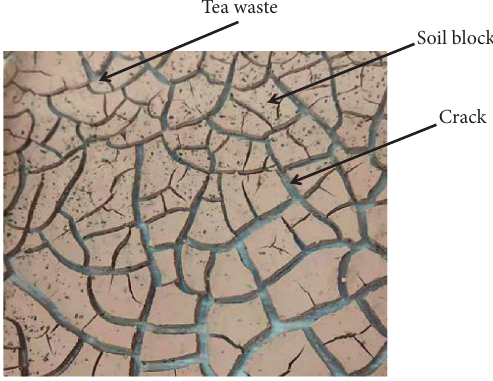
Figure 6: Drying and cracking of tea waste mixed with